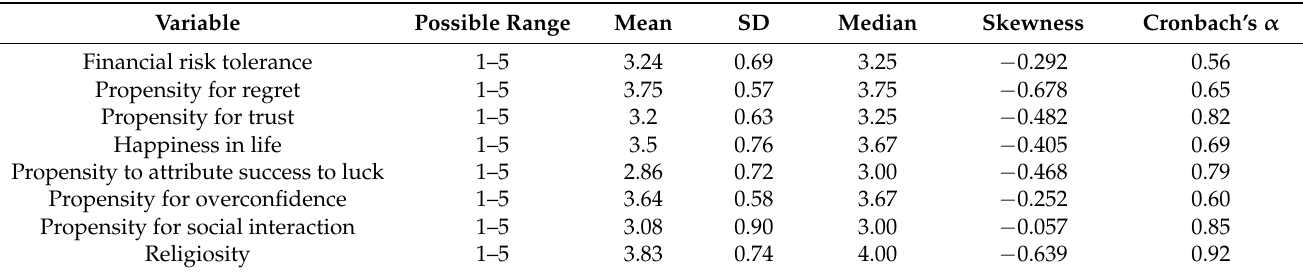
Table 2. Descriptive statistics of